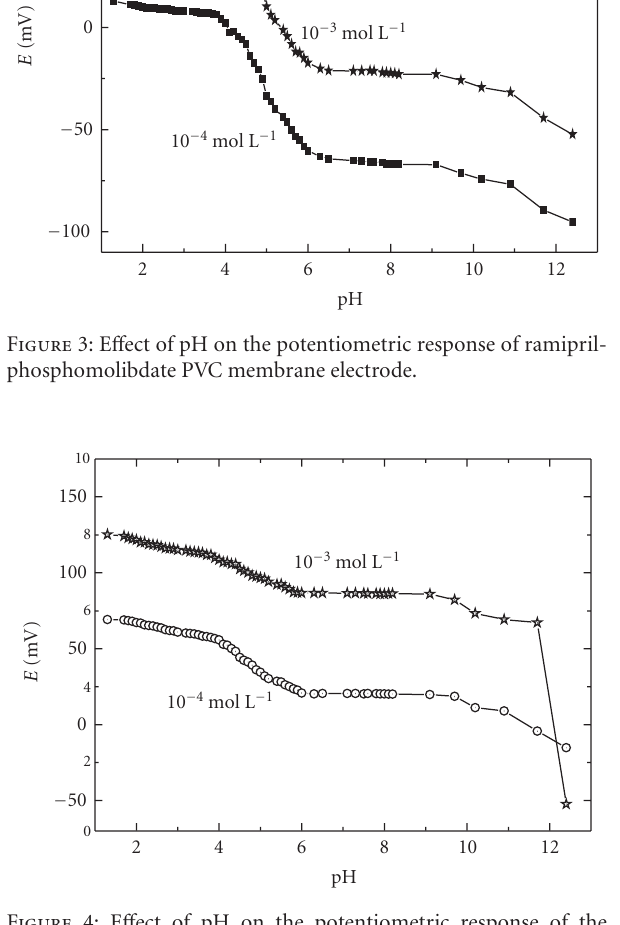
Figure 4: E ff ect of pH on the potentiometric response of the ramipril-tetraphenylborate PVC membrane